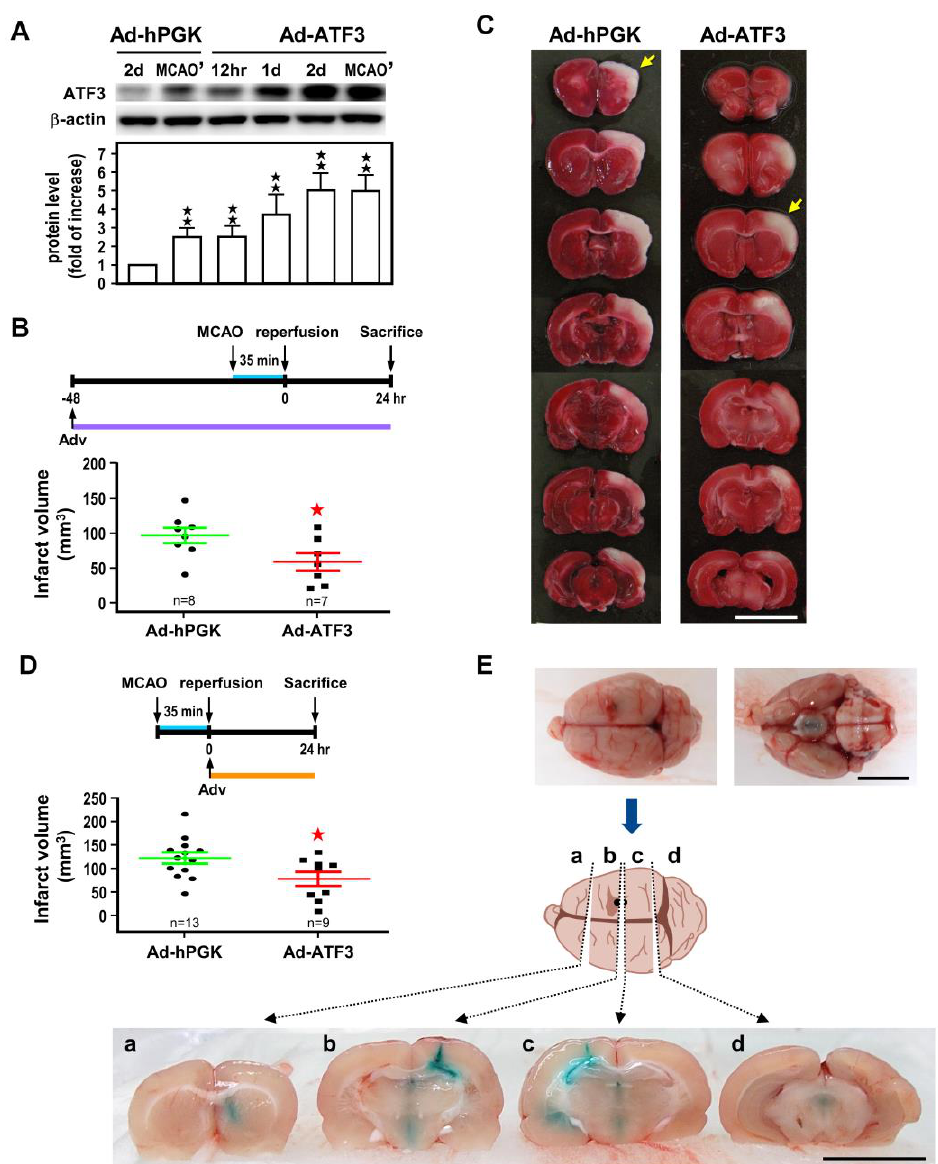
Figure 2. ATF3 overexpression attenuates ischemic brain injury. Rats were subjected to icv infusion of Ad-ATF3 or Ad-hPGK control at 48 h/2 d prior to ( A – C ) or right after ( D ) 35 min of ischemia and infract volume had been determined at 24 h reperfusion. Representative Western blots of ATF3 and β -actin proteins in rat brain infected with adenoviral vectors and densitometric analysis ( A ). Three rats ( n = 3) for each group and each band represents a data point that was extracted from an independent brain sample and no replicates. Symbols 12 h, 1 d, and 2 d represent 12 h, 24 h, and 48 h after adenovirus infection, respectively; and MCAO’ represents after 2 d infection rats were subjected to 35 min of MCA occlusion (MCAO) and 24 h reperfusion ( n = 3). Brain infarct volume in rats treated with Ad-ATF3 or Ad-hPGK at 48 h before 35 min of ischemia ( B ) and representative images of brain infarct ( C ). Brain infarct volume in rats treated with Ad-ATF3 or Ad-hPGK immediately after 35 min of ischemia ( D ). Data are expressed as mean ± SD ( n ≧ 6). ★ p < 0.05 and ★★ p < 0.01 vs. control. Periodic confirmation of proper placement of the needle was performed with infusion of fast green ( E ). White area represents infarct area (yellow arrow). (Bars = 1 cm). ATF3: activating transcription factor 3; Ad-hPGK: rAd-carrying hPGK promoter; hPGK: human phosphoglycerate kinase; rAd: replication-defective recombinant adenoviral; Ad-ATF3: rAd-carrying hPGK promoter-driven ATF3 gene; MCAO: middle cerebral artery occlusion.